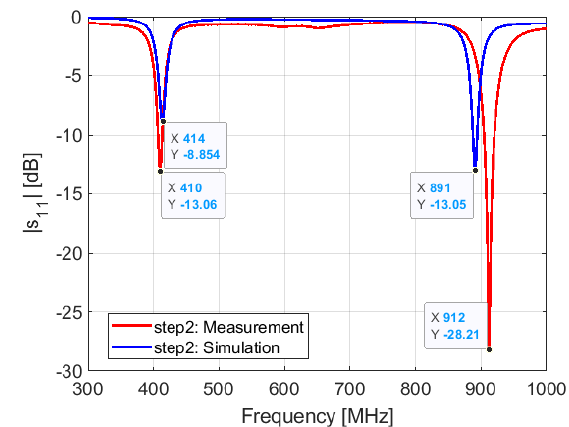
Figure 15. Simulated and measured S11: step 2.